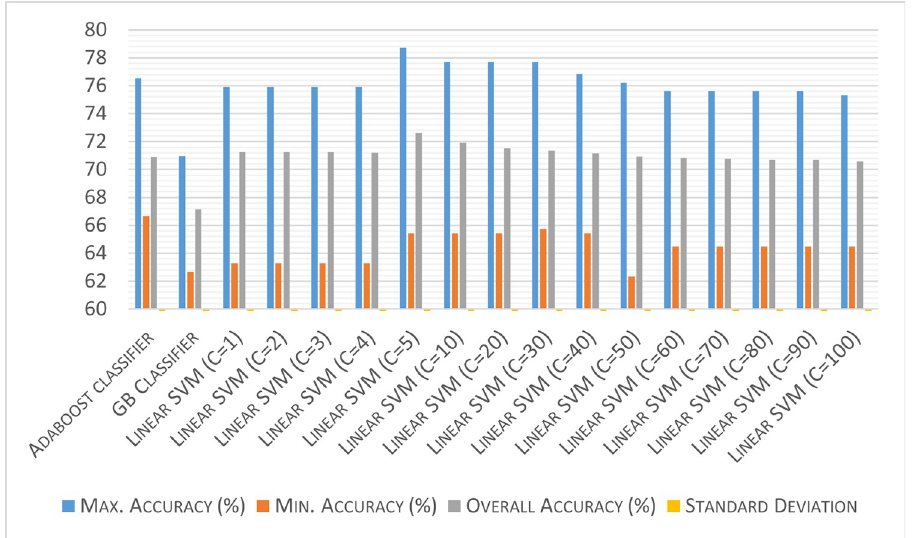
Fig 6. Classification results using gaussian transformation on the dataset after ranking the numerical